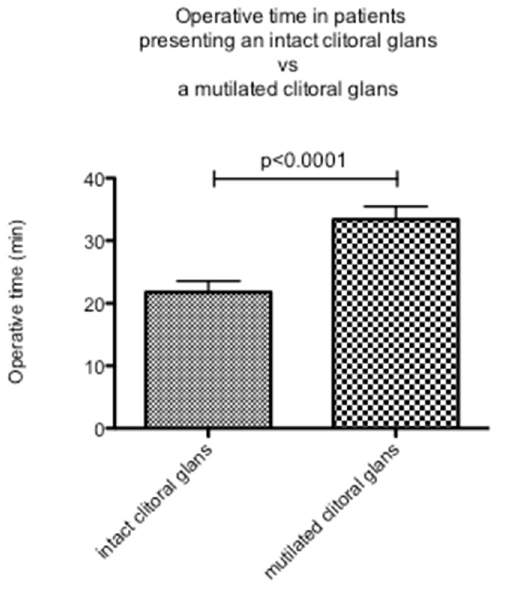
Figure 3. Operative time in patients with an intact clitoral glans compared to patients with a com-